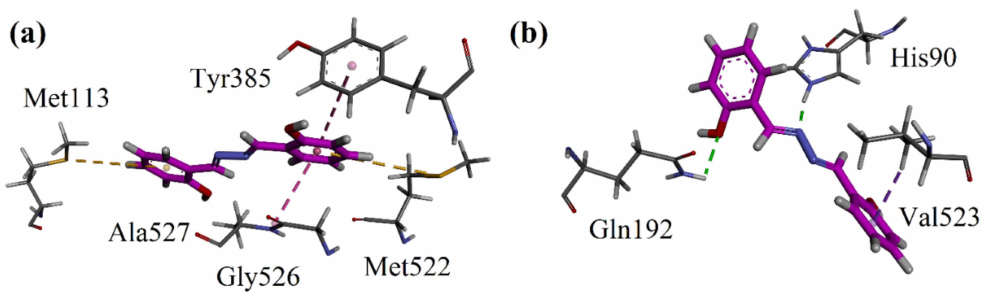
Figure 4. Close-up 3D interaction plot of salicyalazine in the binding site of ( a ) COX-1 and ( b ) COX-2. 2.8.2. Docking Studies on µ -Opioid and GABA A Receptors by Using MOE Software Three-dimensional crystal structures of µ -opioid and GABA A receptors were acquired from PDB with accession codes 5C1M and 4COF, correspondingly. The 3D ribbon diagram of salicyalazine into the binding site of µ -opioid (5C1M) is shown in Figure 5a. The 3D interaction plot of the purified salicyalazine showed a hydrogen bond interaction with Trp318. His54 forms π - π interactions with the phenyl ring. Hydrophobic interaction of the π -alkyl type was also observed (Figure 5b).